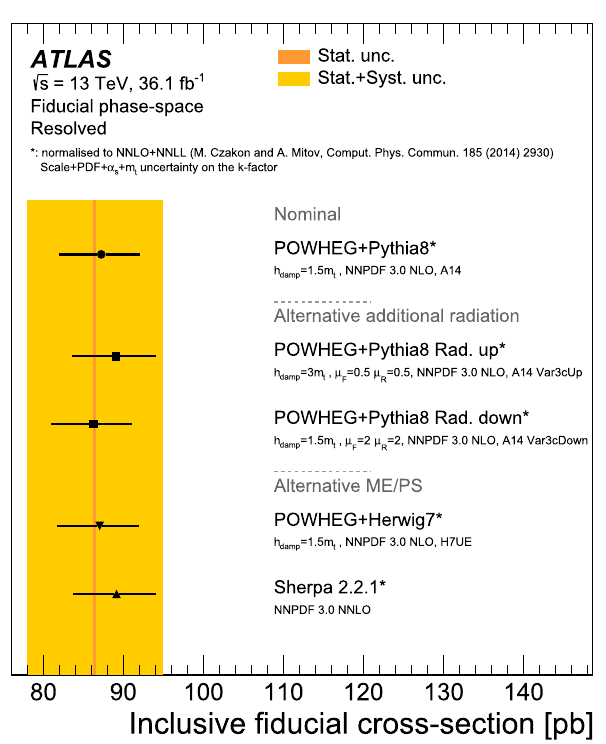
Fig. 36 Comparisonofthemeasuredinclusivefiducialcross-sectionin the resolved topology with the predictions from several MC generators. The bands represent the statistical and total uncertainty in the data. The uncertainty on the cross-section predicted by each NLO MC generator only includes the uncertainty (due to PDFs, m t and α s ) affecting the k -factor used in the